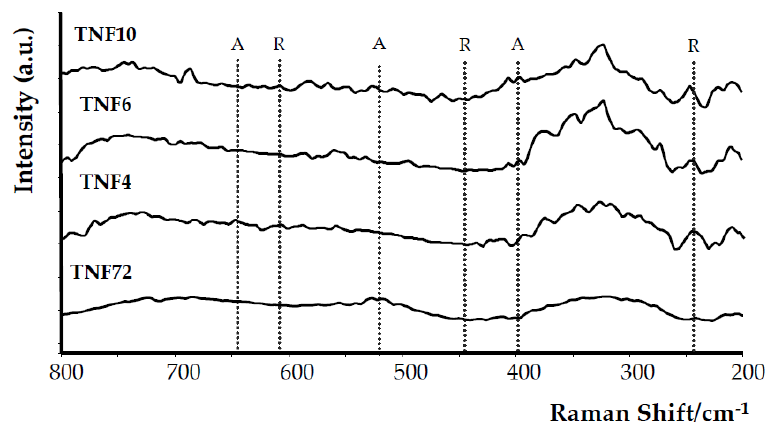
Figure 4. Raman spectra of studied TNF samples (the dashed line indicates the potential positions of the bands derived from the TiO 2 anatase phase (A) and rutile phase (R)).